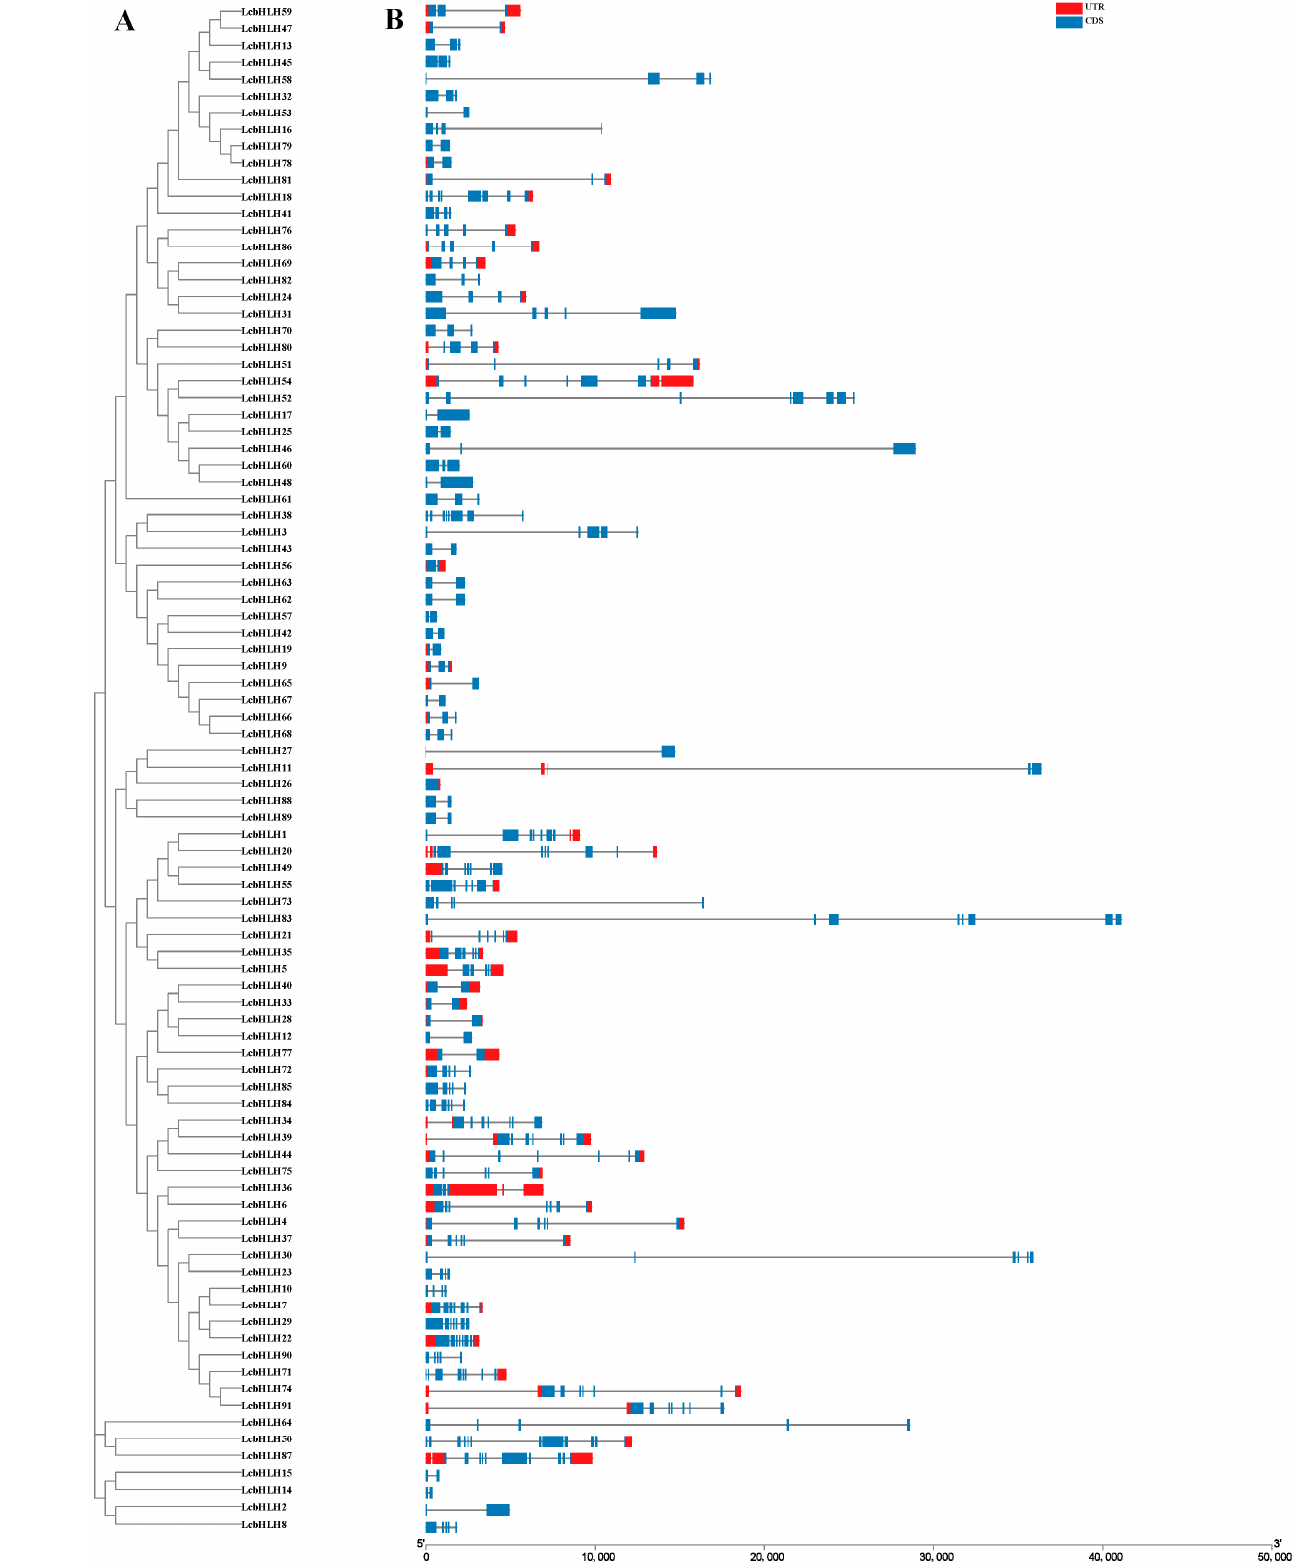
Figure 2. Phylogenetic relationships and exon/intron structures of LcbHLH protein. ( A ) The phylogenetic tree of LcbHLH protein. ( B ) Exon/intron structure analysis of LcbHLHs. Blue boxes represent CDS, red boxes represent UTR, and gray lines represent introns. The size of exons and introns can be estimated by the scale at the bottom.